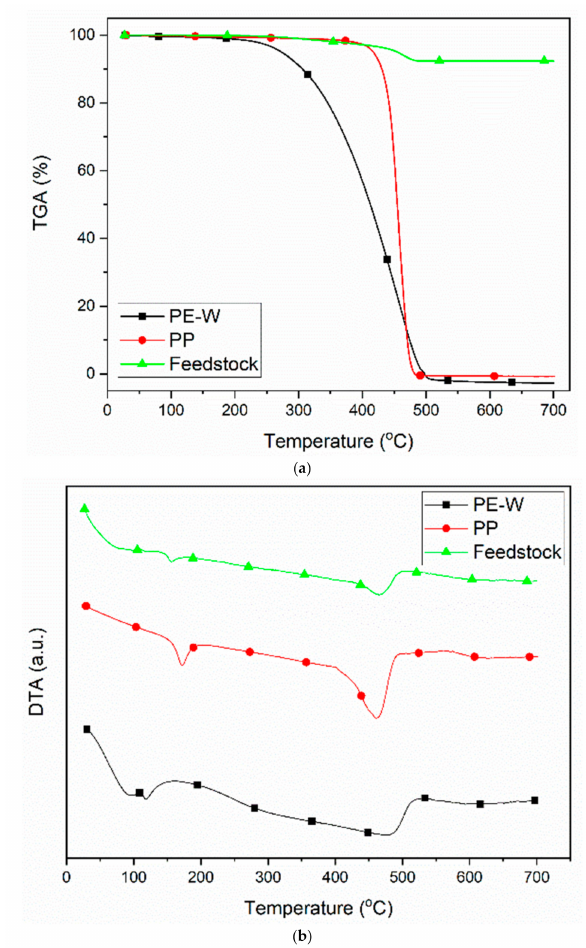
Figure 4. ( a ) TG and ( b ) DT analysis curves of feedstock and